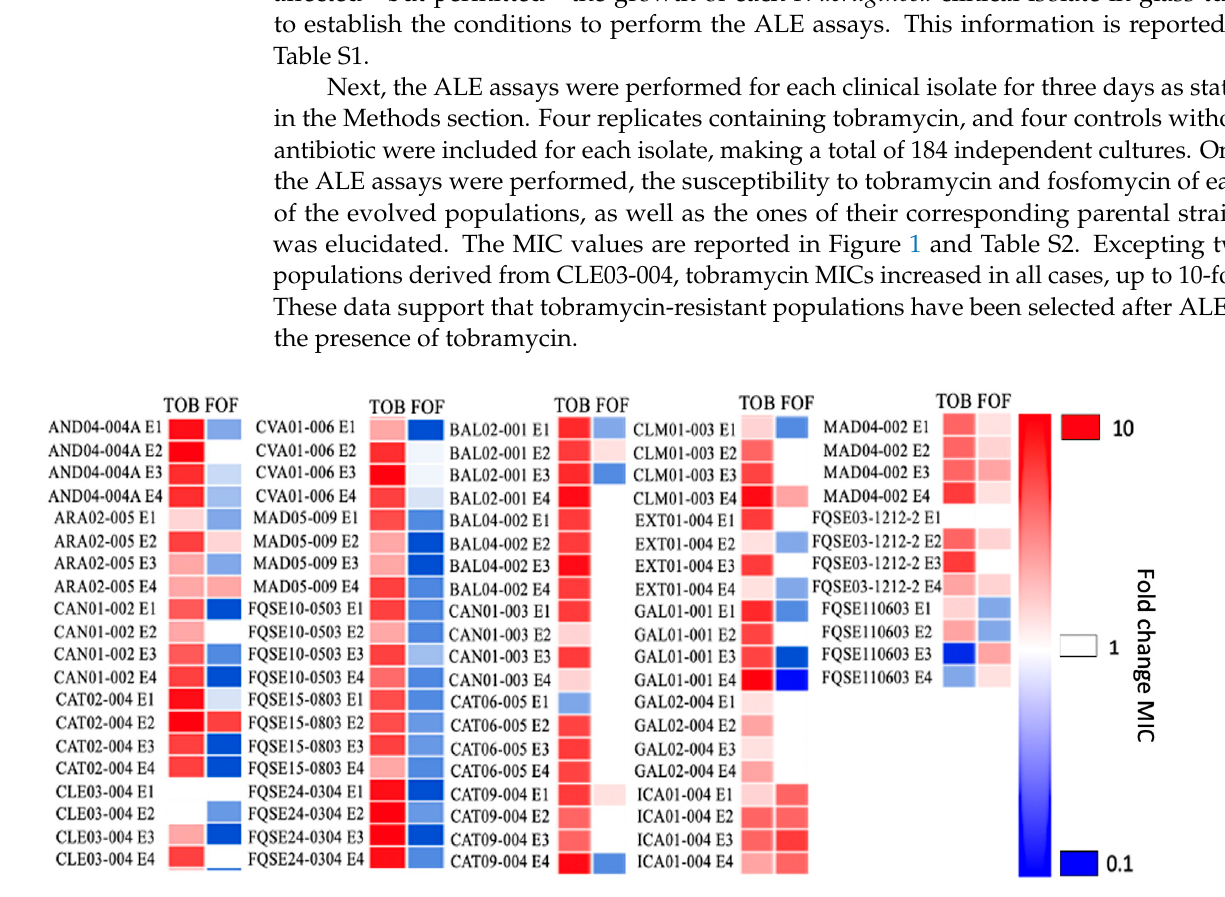
Figure 1. Diagram showing the susceptibility to tobramycin and fosfomycin in clinical isolates of P. aeruginosa subjected to short-term ALE in the presence of tobramycin. Susceptibility to tobramycin and fosfomycin was analyzed in 23 clinical isolates (reported in Table 1), 4 replicate populations each—indicated as E1, E2, E3, or E4—subjected to ALE in the presence of tobramycin for three days. Intensity of the color is proportional to fold change of MIC regarding the mean value of the control populations’ MIC. The evolved populations were classified as “resistant” (red) or “susceptible” (blue). Collateral sensitivity to fosfomycin was observed in nine out of the 23 clinical isolates of P. aeruginosa . MIC values ( μ g/mL) of parental strains and populations evolved in the presence/absence of tobramycin, are included in Table S2. TOB: tobramycin, FOF: fosfomycin. The strains that developed collateral sensitivity to fosfomycin were determined as those that, in at least two out of four of the evolved replicates, showed a fosfomycin’s MIC equal or lower than half of the mean value of the controls’ ones. Then, the results